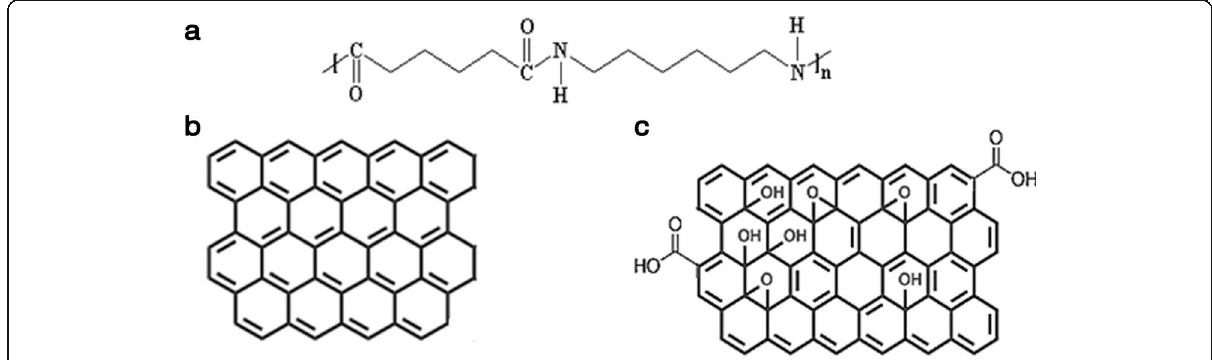
Fig. 1 Chemical structures. a N6,6. b Graphene. c